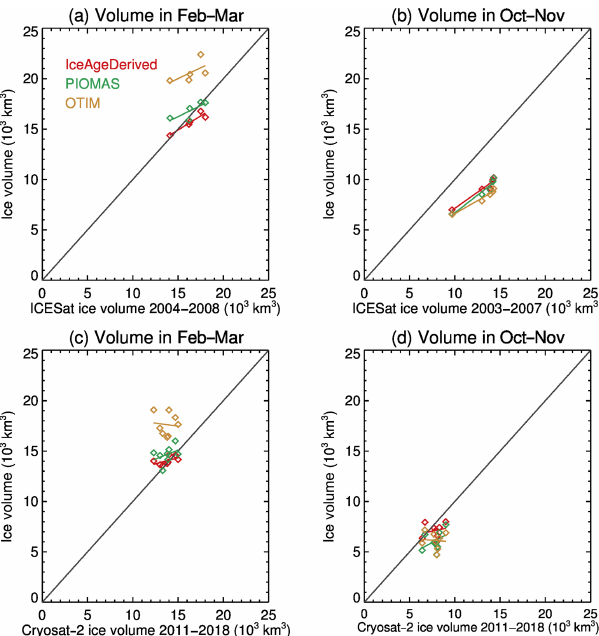
Figure 6. Comparison of monthly ice volume from the IceAgeD- erived product, PIOMAS, and OTIM to ice volume from ICESat (2004–2008) and CryoSat-2 (2011–2018) over the Arctic Ocean.